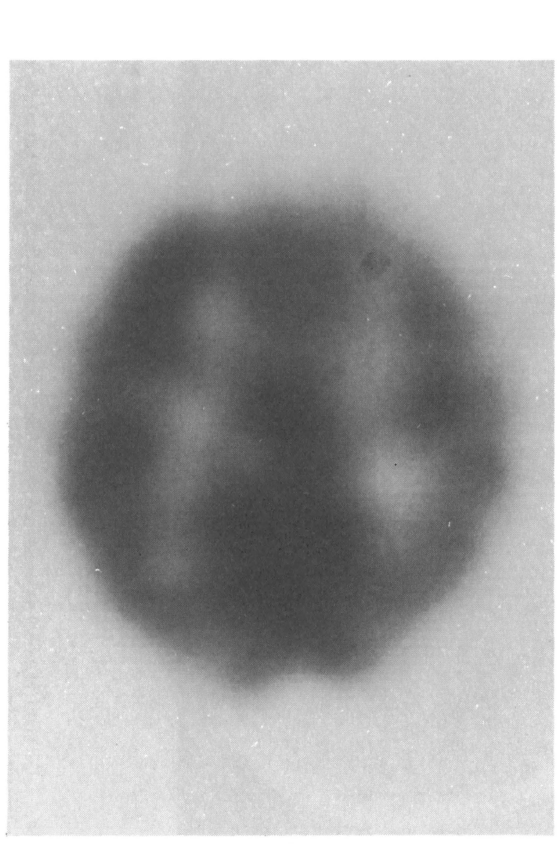
FIG. 4. SPECT at the acute stage showing decreased accumu lation of 1231-IMP in the left middle cerebral artery